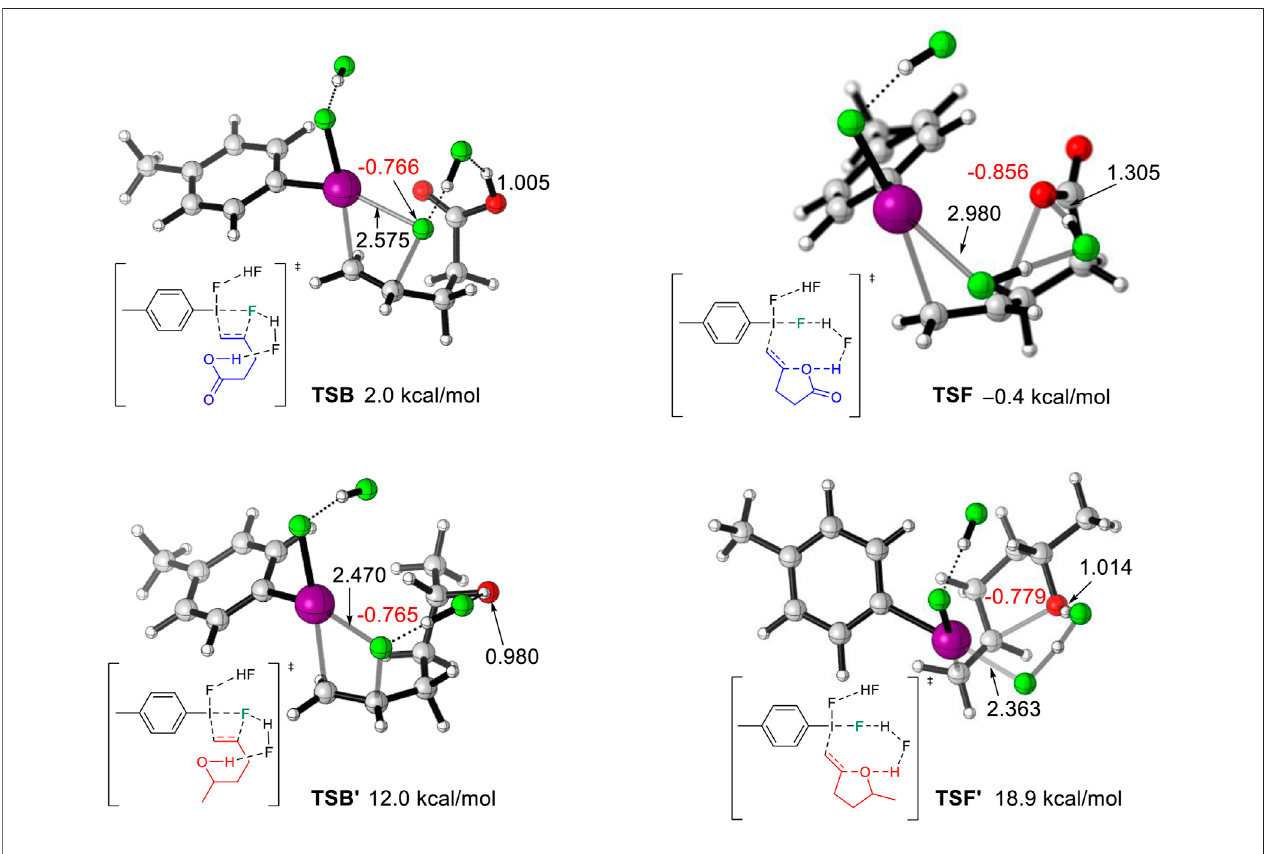
FIGURE 5 | Optimized structures of key transition